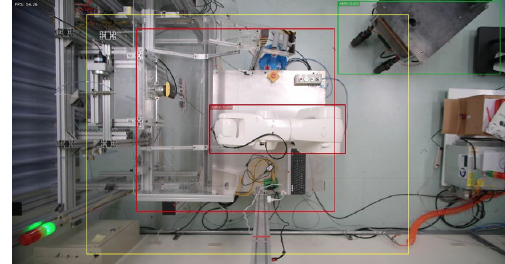
Figure 12. AMR enters warning range.